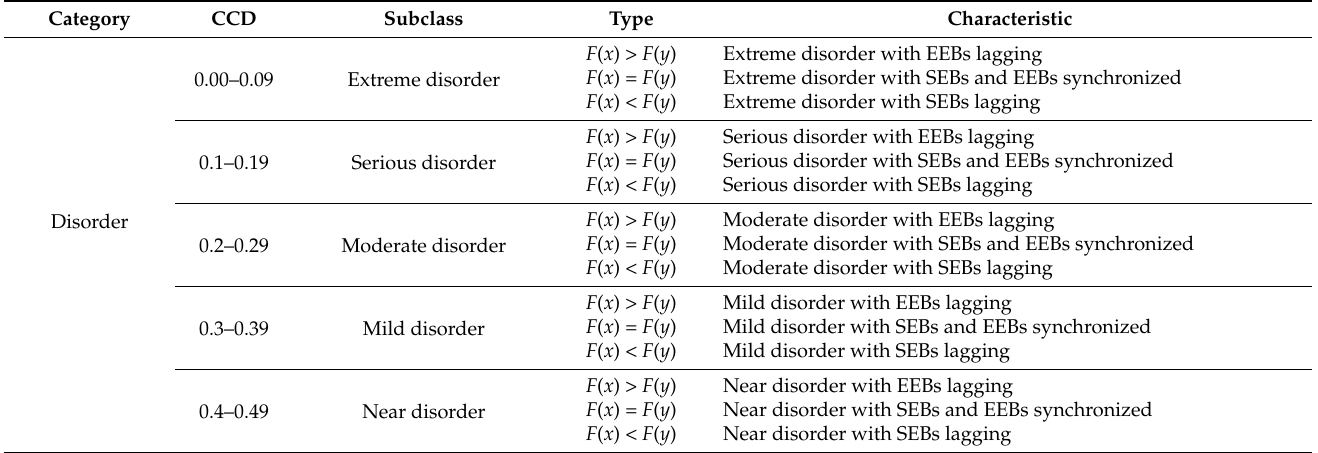
Table 4. Classification of CCD of SEBs and EEBs systems of